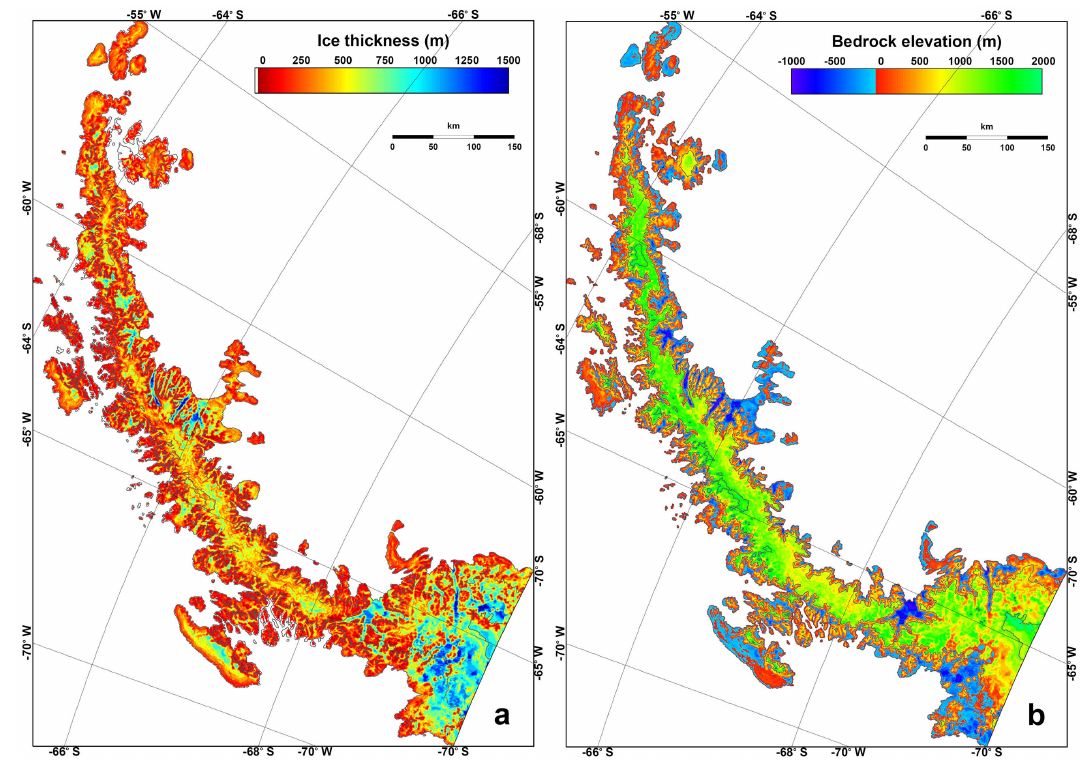
Figure 8. Inferred (a) ice thickness distribution and (b) bedrock elevation of the Antarctic Peninsula.